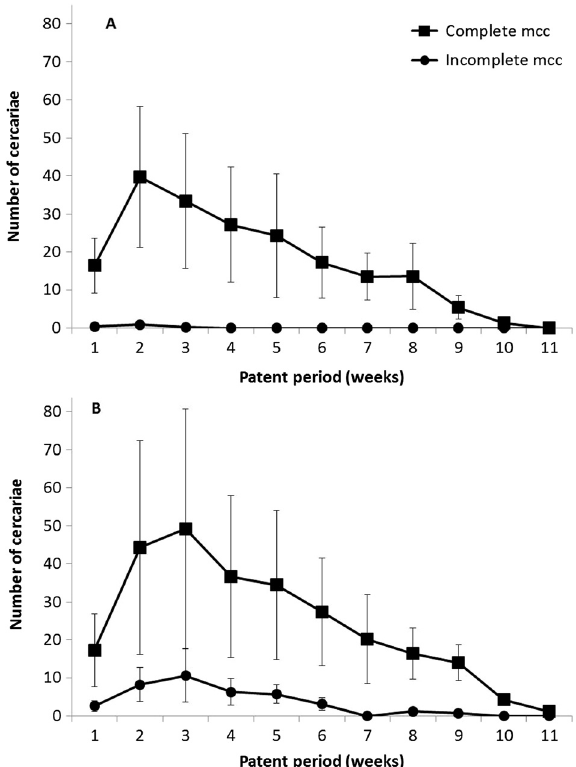
Figure 1. Distribution of F. hepatica metacercariae (mcc) for controls (A) and temperature-challenged snails (B) correlated to length of patent period (expressed in weeks). The values noted for controls from both snail populations were pooled. A similar process was also used for values coming from temperature-challenged snails.